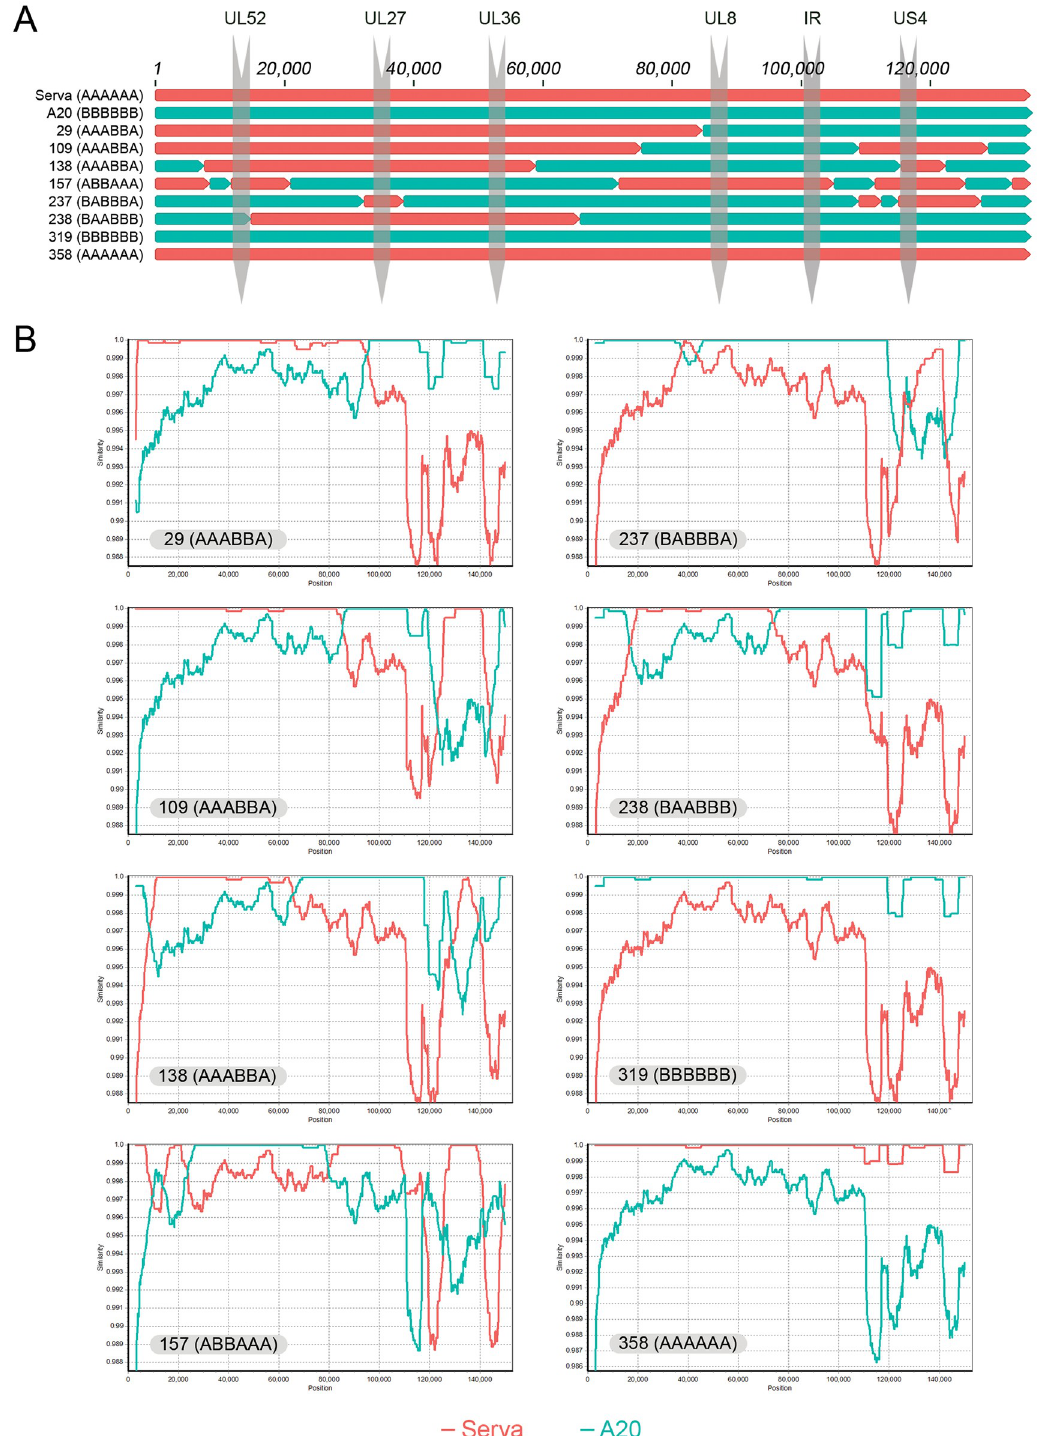
Fig 7. Schematic view of the genomic composition of the isolates sequenced in this study (A) and sequence similarity plots (B) of isolate #29, #109, #138, #157, #237, #238, #319 and #358 with those of Serva and A20. The plots were generated using SimPlot v3.5.1 set to scan the sequences with 6000 bp sliding windows, which were moved across the alignments in 200 bp steps.